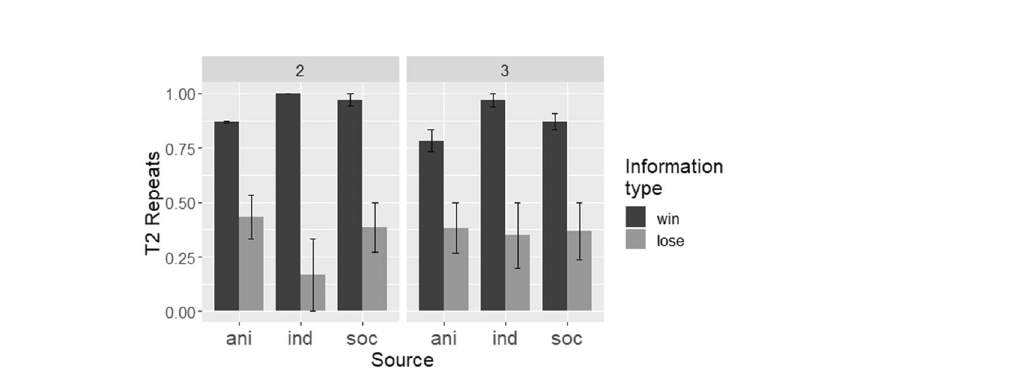
Figure 2. Task-proficient monkeys’ performance (as measured by T2 repeats), by source, information type, and array size. Bars show means of by-participant means, and error bars show bootstrapped 95% confidence intervals. ani animated cue, ind individual, soc